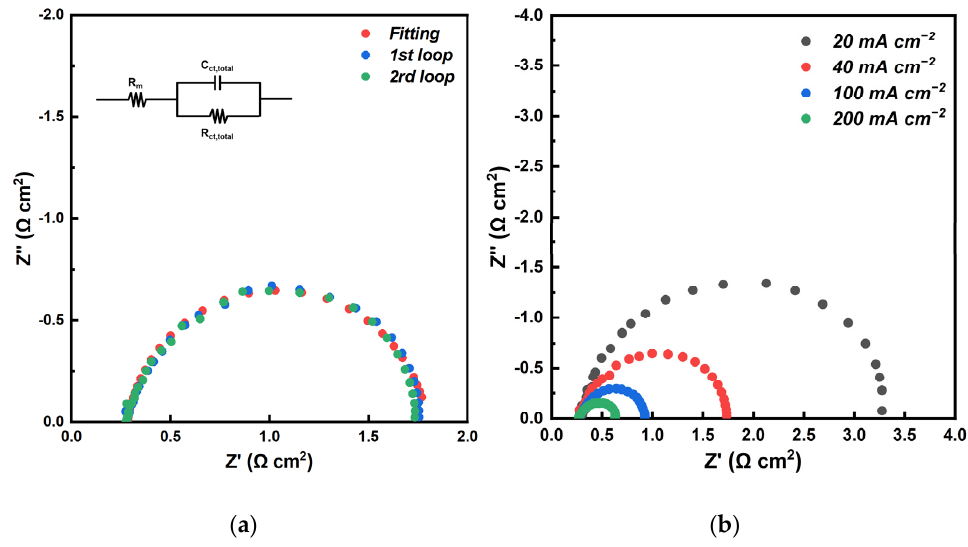
Figure 10. ( a ) Nyquist plots for two loops and for the fitting plot of the equivalent circuit under 0% RH gas conditions, with current density of 20 mA cm − 2 . ( b ) Nyquist plots for different current densities under 0% RH gas conditions. (at 160 °C, equal H 2 and O 2 flow rates at 0.4 L min − 1 ).